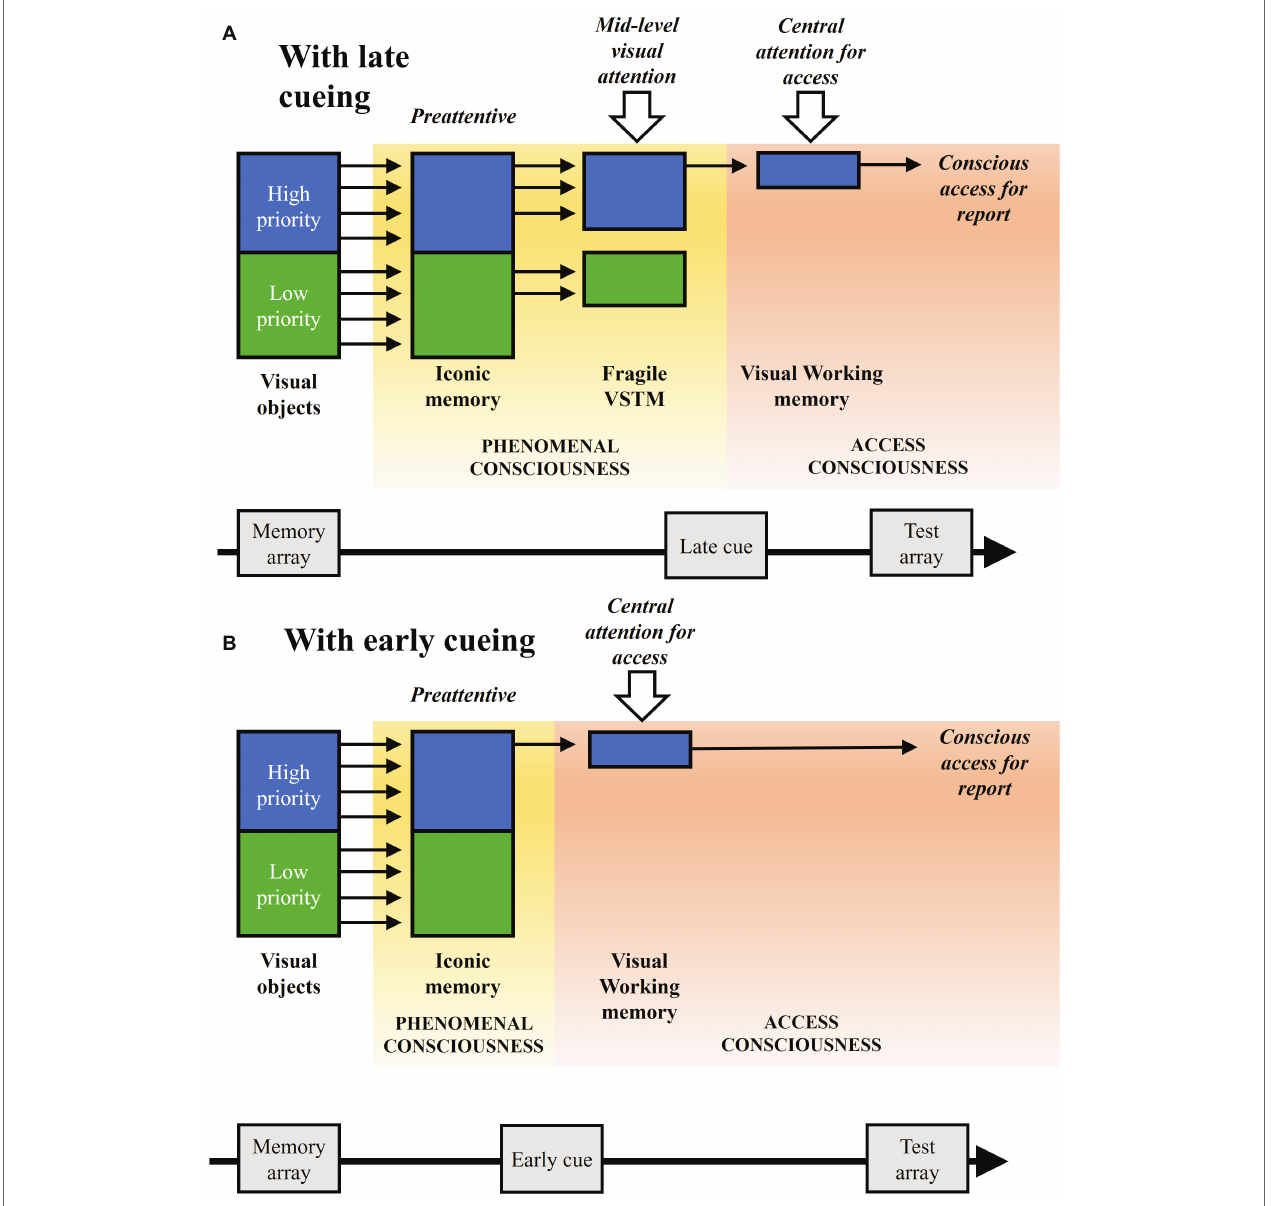
FIGURE 4 | Illustration of the visual processing and maintenance stages associated to the experimental paradigm, with their related attention and consciousness components, considering the theoretical implications of the study and other supporting empirical and theoretical research. (A) The implicated stages with late cueing. Low- and high-priority visual objects are presented and then preattentively represented in iconic memory, as a first component of phenomenal consciousness. At a subsequent fragile visual short-term memory (VSTM) stage object representations are biased in a time-dependent manner by a mid-level visual attention based on their priority, as a second component of phenomenal consciousness. When the cue appears, access consciousness takes place directed by a central attention, as related to encoding in visual working memory. Access consciousness further operates for report, as related to retrieval from visual working memory. (B) The direct transition from iconic memory to the stage of conscious access with early cueing, without the intermediate stage of the fragile VSTM and with a longer visual working memory maintenance, thus with a shorter stage of phenomenal consciousness and a longer stage of access consciousness as compared to the condition with late cueing illustrated in (A)